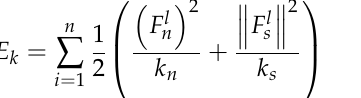
Figure 6. Schematic diagram of AE event failure mode in particle model.